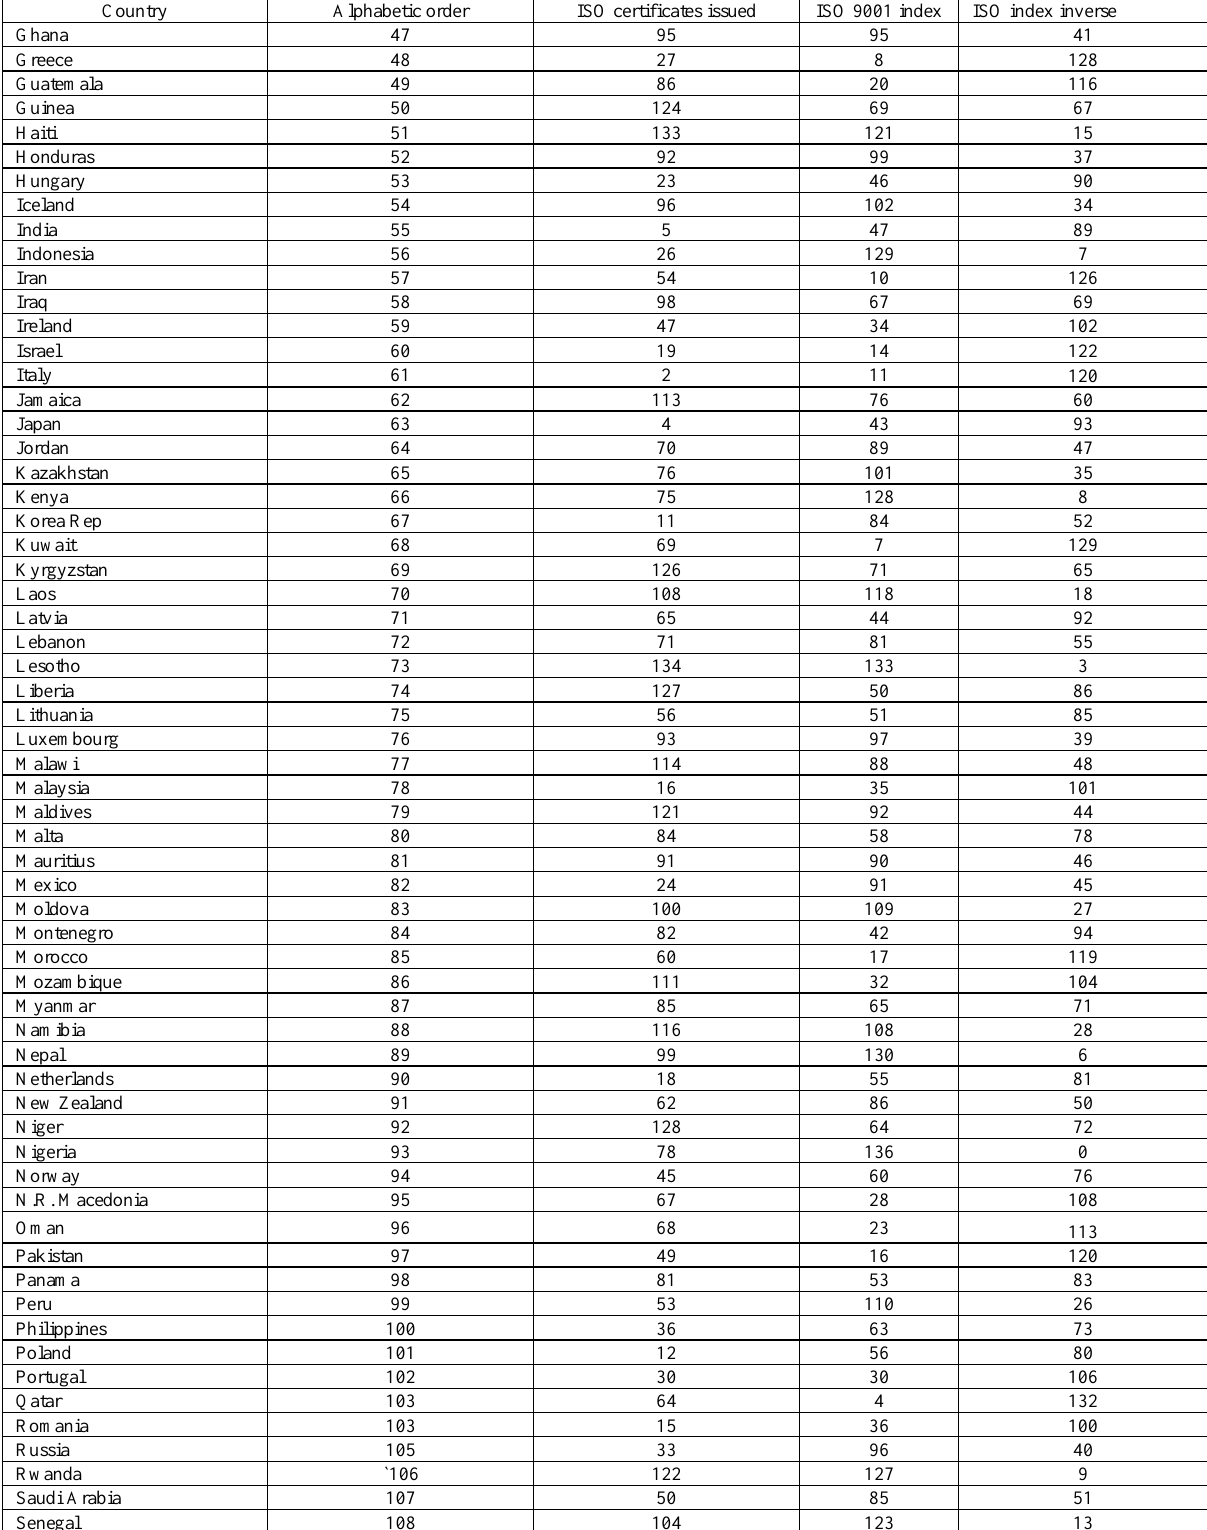
Table 4 (cont.). The rank of countries as per the alphabetic order, number of ISO 9001 certificates, and as per the ISO 9001 index (136 countries